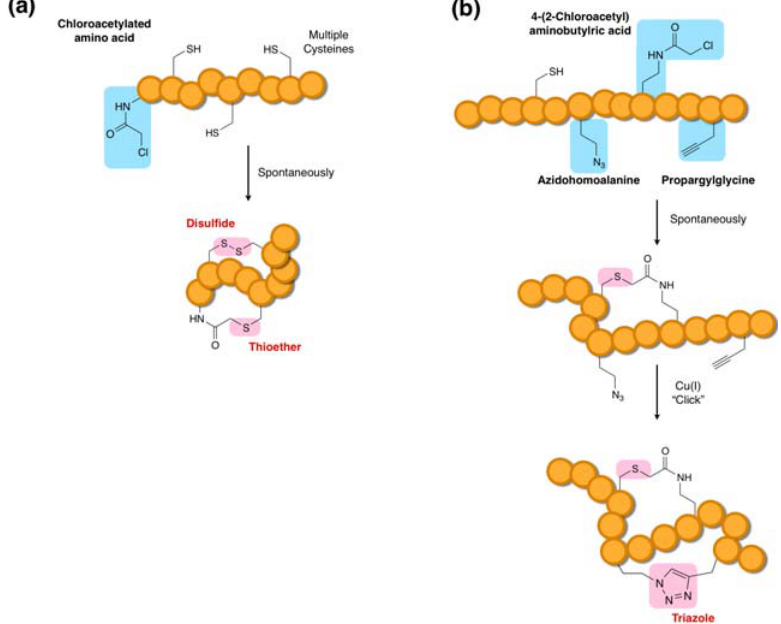
Figure 5. Ribosomal synthesis of bicyclic peptides. ( a ) Synthesis of an overlapped bicyclic peptide coupled with thioether and disulfide bond formations [45]. ( b ) Synthesis of a bicyclic peptide coupled with post-translational ring closure by a “click” cycloaddition reaction. The azide group of azidohomoalanine reacts with the alkyne group of propargylglycine to form a triazole moiety in a reaction catalyzed by Cu(I)